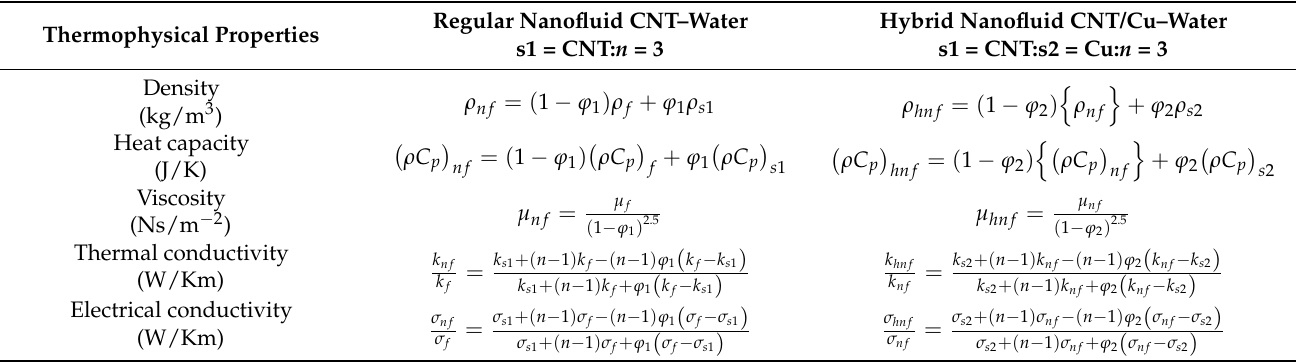
Table 1. The effective properties of nanofluid types.